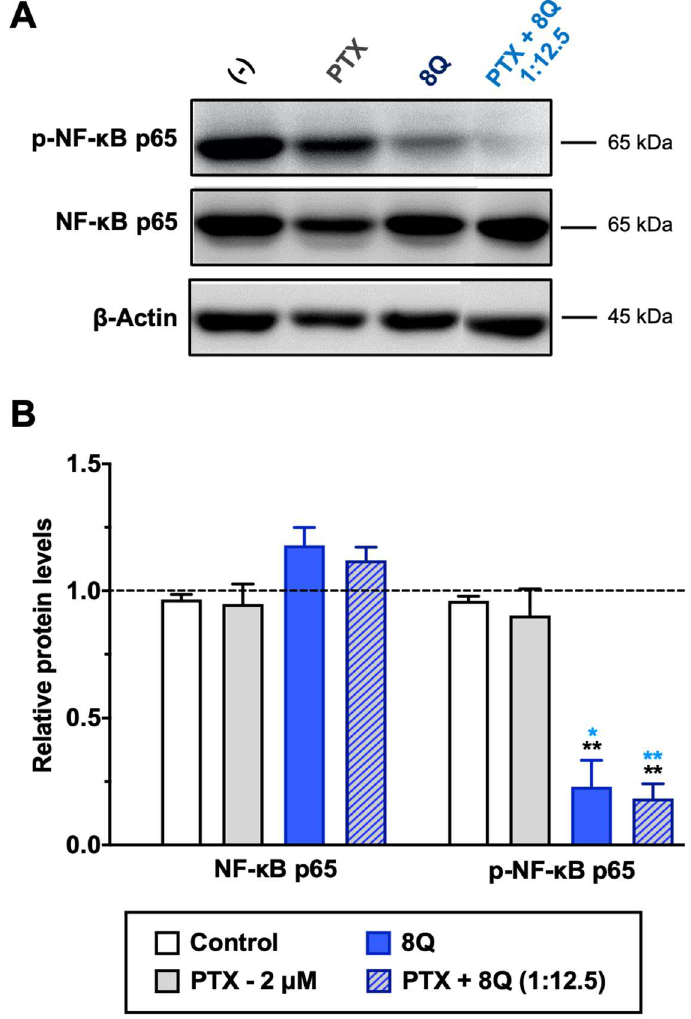
Figure 7. Effect of 8Q and PTX treatments on the NF-κB signaling pathway in MDA-MB-231 cells. ( A ) Representative Western blots of total and phosphorylated NF-κB p65 protein levels upon treatment with PTX, 8Q or their combination (2 µM and 25 µM, respectively). The β-actin protein expression level was used as a loading control. ( B ) Quantification of band intensity in Western blots. The results are expressed as normalized protein levels, referred to β-actin expression, represented as mean ± SEM of three independent experiments. Statistic t-test analysis of 8Q and combined therapy was done in comparison with control non-treated cells (black asterisks, ** p < 0.01) as well as with PTX treatment (blue asterisks, * p < 0.05 and ** p < 0.01).